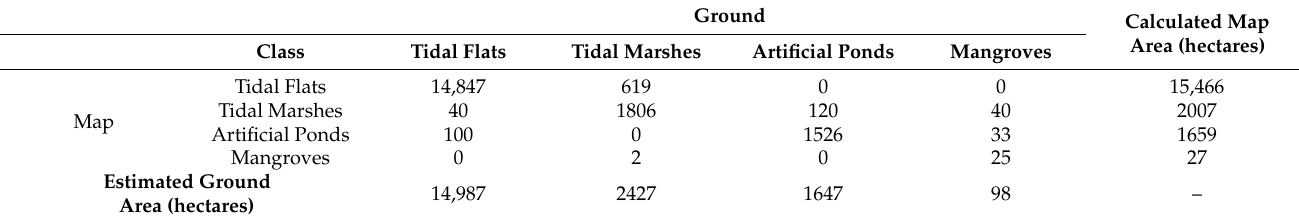
Table 3. Confusion matrices of the classification results for 2021. Ground Tidal